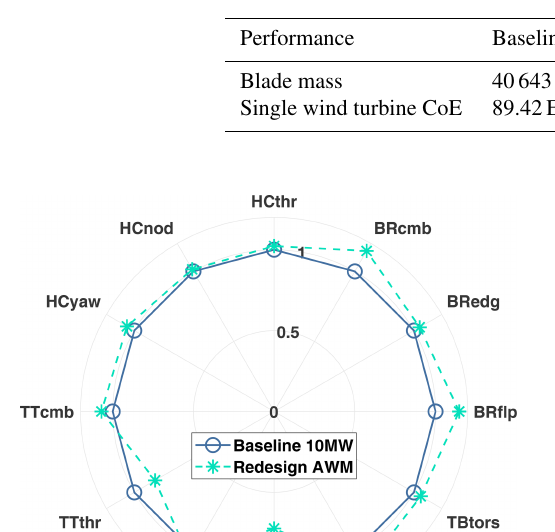
Figure 8. Weibull weighted DEL increases as a function of amplitude and Strouhal number. (a) Blade root flap-wise moment. (b) Tower base FA moment. Table 3. Comparison between the KPIs of the Baseline 10MW and the redesigned rotor.